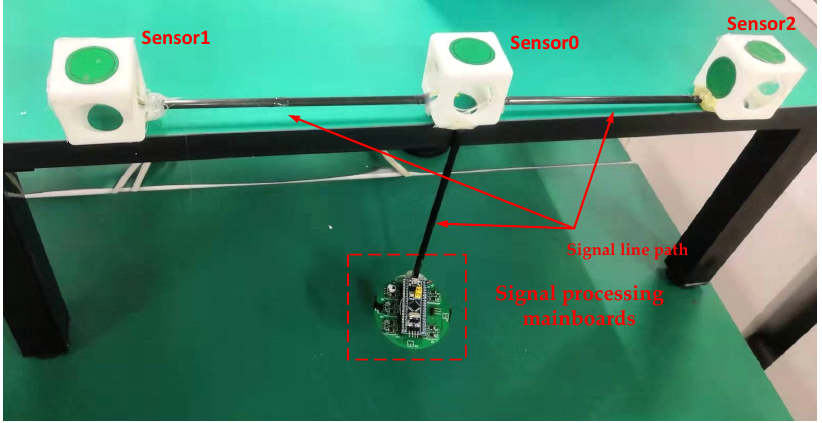
Figure 17. Physical view of the sensor array.